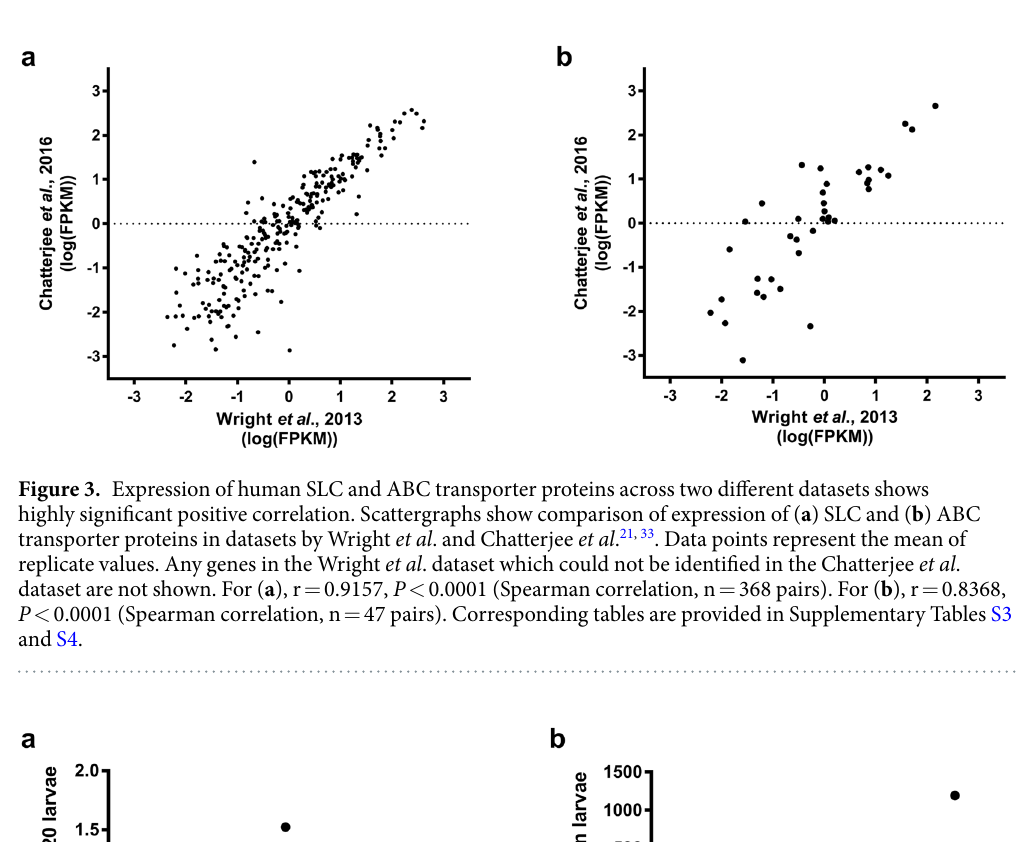
compounds excluded from the larvae.